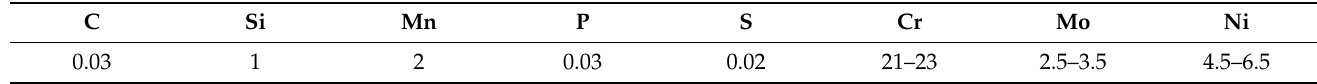
Table 1. S31803 chemical composition requirements (%).